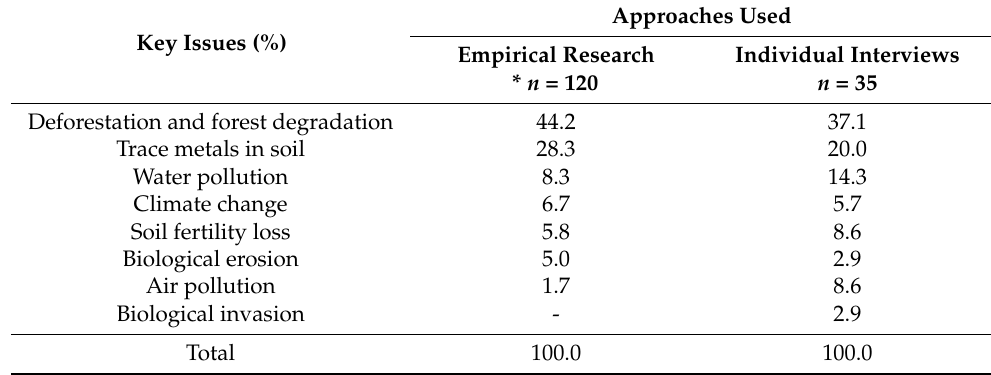
Table 3. Environmental problems identified by the literature review on the Katangan Copperbelt.